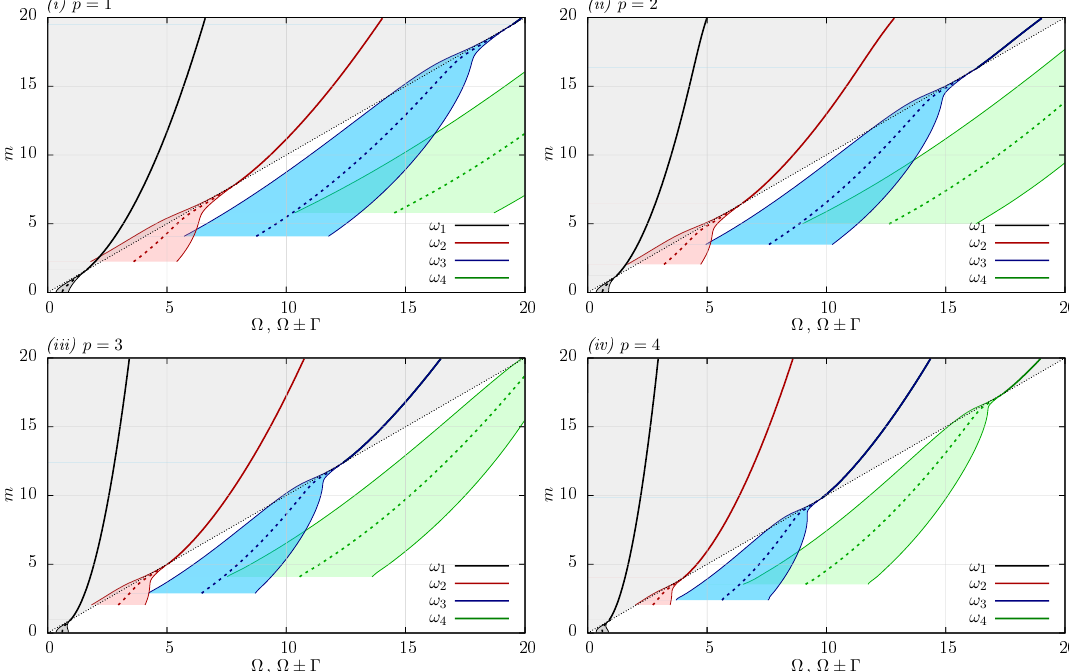
Figure 7 . Oscillational and resonance modes for the Lin-Piette potentials p = 1 ; 2 ; 3 ; 4 with the pion mass m [0 ; 20]. The real parts of the quasinormal mode frequencies are depicted with dashed 2 lines and their widths (imaginary parts) with shaded regions.